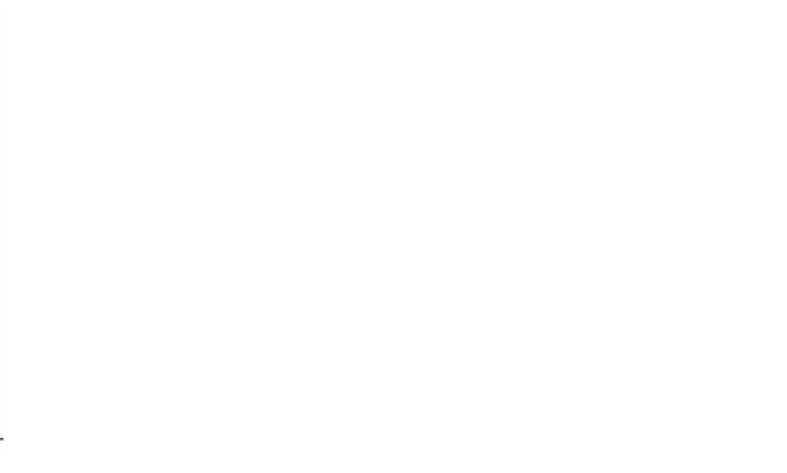
Figure 3. Early pupa of Rhynchaenus maculosus . Exarate in type, fusiform in shape, and creamy-white body with sparse